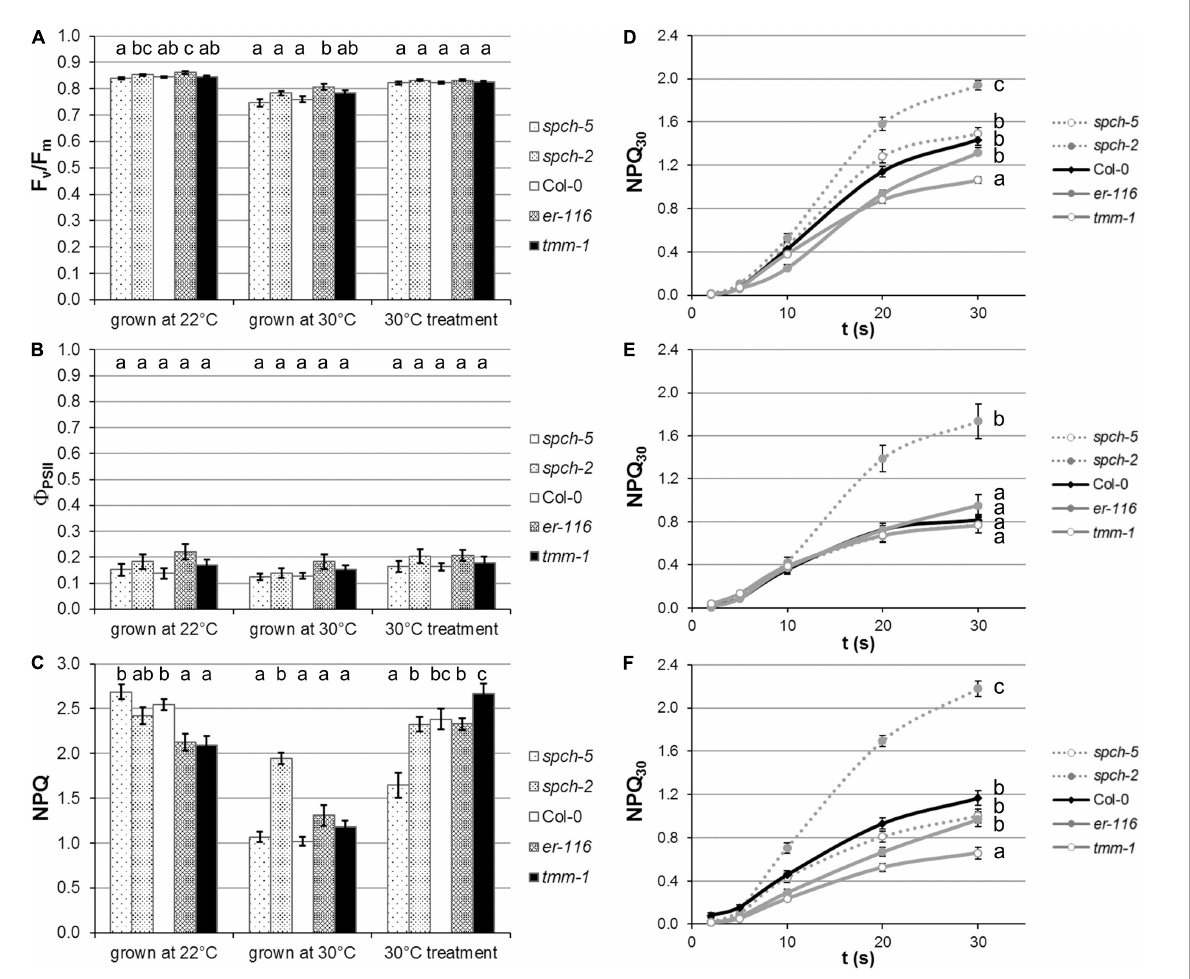
FIGURE6 Impact of temperature regime on plant performance. Photosynthetic activity is evaluated in terms of (A) maximal efficiency of PSII (F V /F M ), as well as (B) quantum yield of PSII in steady state ( (cid:56) PSII ). (C) The capacity for energy dissipation in the chloroplast is analyzed by the non-photochemical quenching in steady state (NPQ). Kinetics of NPQ activation in plants grown at (D) optimal conditions (22 ◦ C), (E) supra-optimal temperature (30 ◦ C), and (F) after a short-term treatment at 30 ◦ C. Values are means ± SE ( n = 20). Different letters above the bars indicate statistically significant differences between genotypes at the same growth temperature ( p ≤ 0.05) according to one-way ANOVA followed by the Dunnet’s T3 test (30 ◦ C treatment data in panel A ), the Tukey’s test (F) , or the Kruskal–Wallis test followed by the Dunn’s test (the rest of